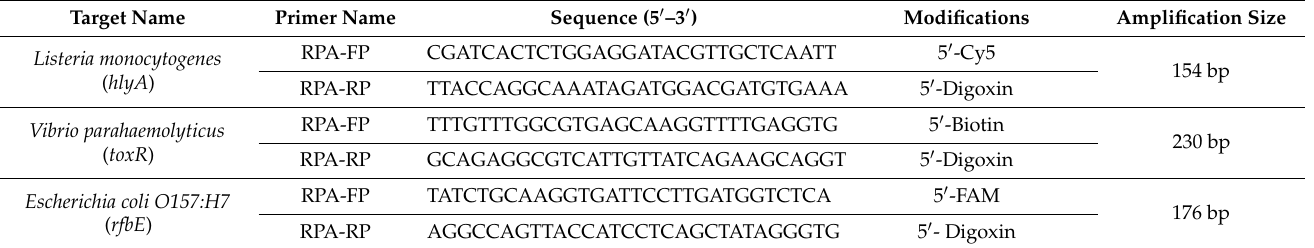
Table 2. Sequences of RPA primers used for Listeria monocytogenes , Vibrio parahaemolyticus , and Escherichia coli O157:H7 . CY5: cyanine 5; FAM: carboxy fluorescein; FP: forward primer; RP: reverse